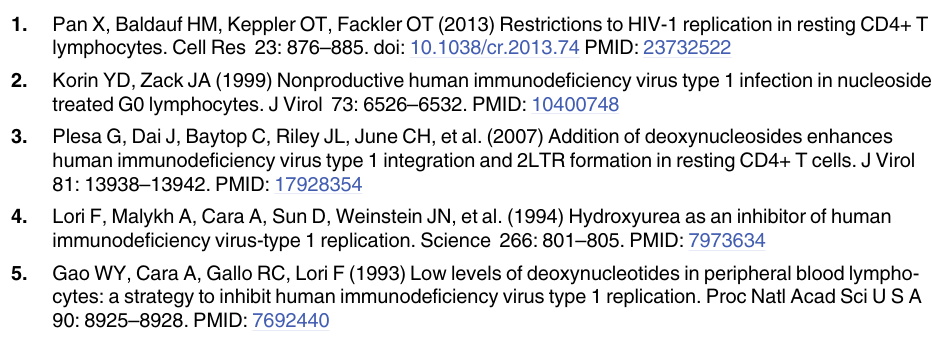
S1 Table. Information of chemicals and